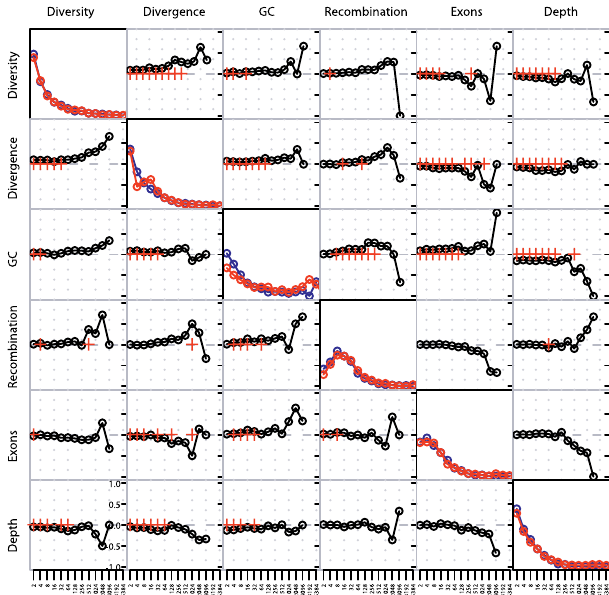
Figure 2. Power Spectra and Pairwise Correlations of Detail Wavelet Coefficients Diagonal plots show the power spectrum of the wavelet decomposition of each factor on the long (red) and short (blue) arms of Chromosome 20. Off-diagonal plots show the rank correlation coefficient between pairs of detail wavelet coefficients at each scale on the long (top right) and short (bottom left) arms. Red crosses indicate significant correlations ( p -value , 0.01; Kendall’s rank correlation). Scale is shown in kilobases. DOI: